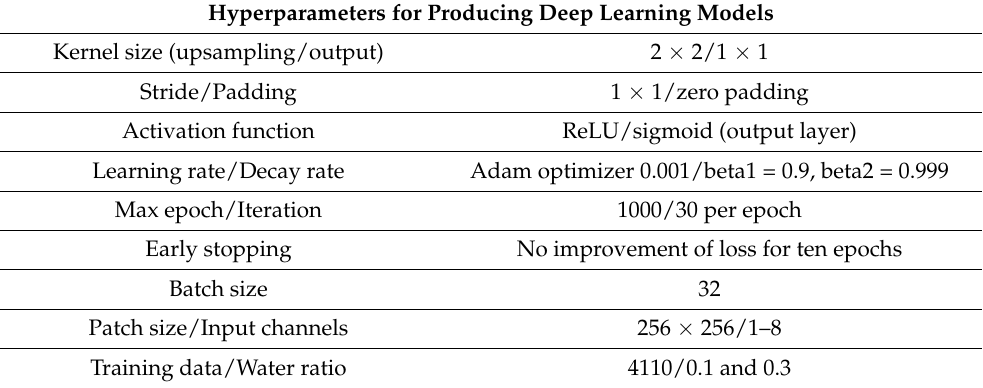
Table 1. Hyperparameters for producing deep learning models for the flood monitoring system. Hyperparameters for Producing Deep Learning